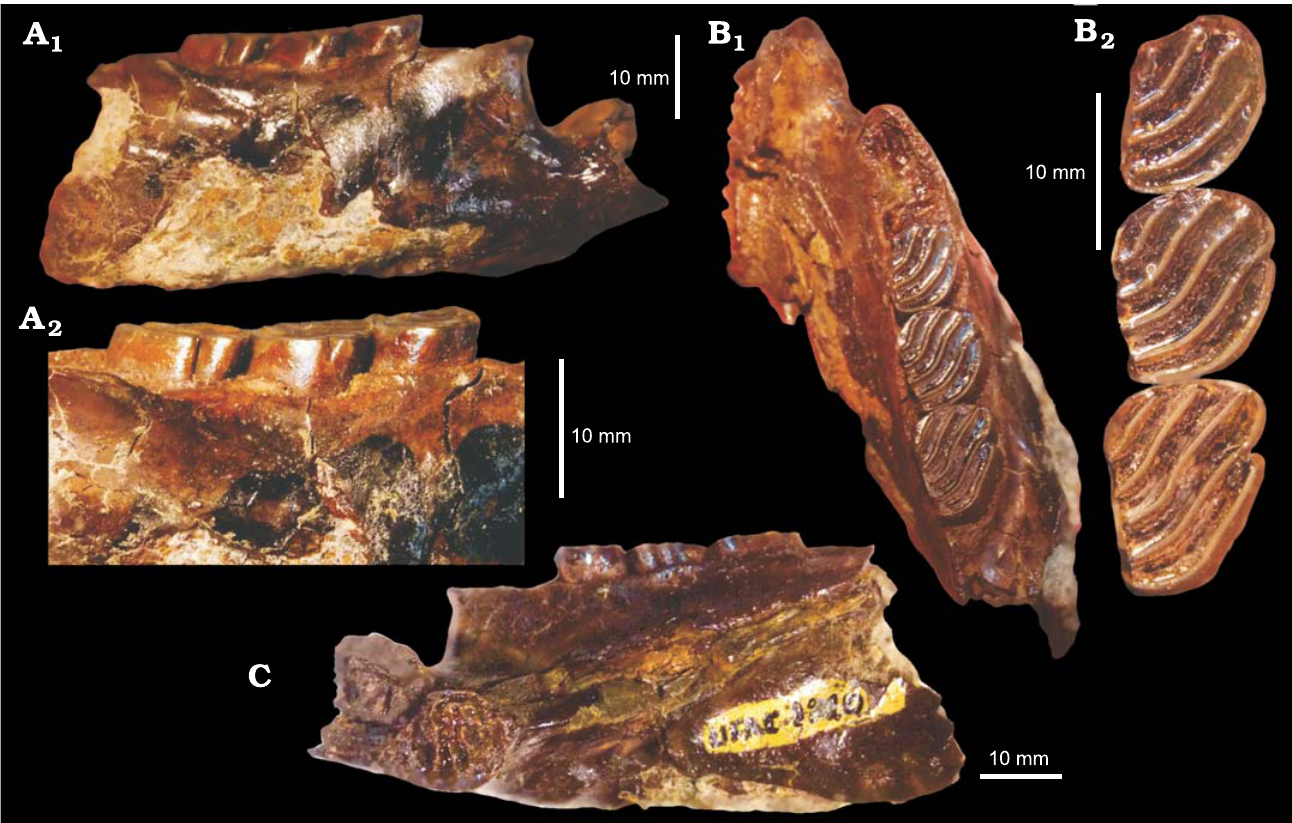
Fig. 4. Right dentary and m1–m3 series of potamarchine rodent Potamarchus murinus Burmeister, 1885 (UFAC 1820) from Solimões Formation, Late Miocene, Brazil; in lateral view ( A ), showing detail of the labial view of the cheek teeth (A 2 ); occlusal view ( B ), showing detail of the occlusal view of the cheek teeth (B 2 ); and medial view ( C